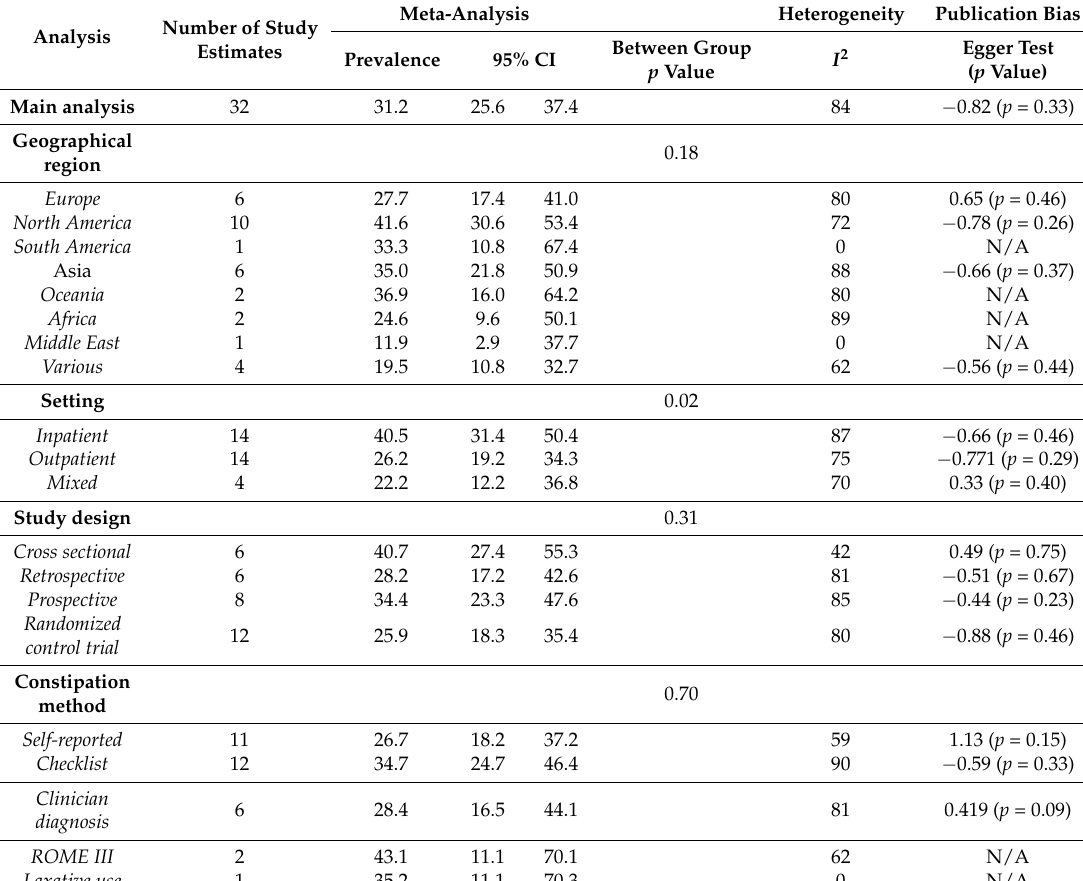
Table 1. Subgroup analyses of moderators of constipation in people treated with